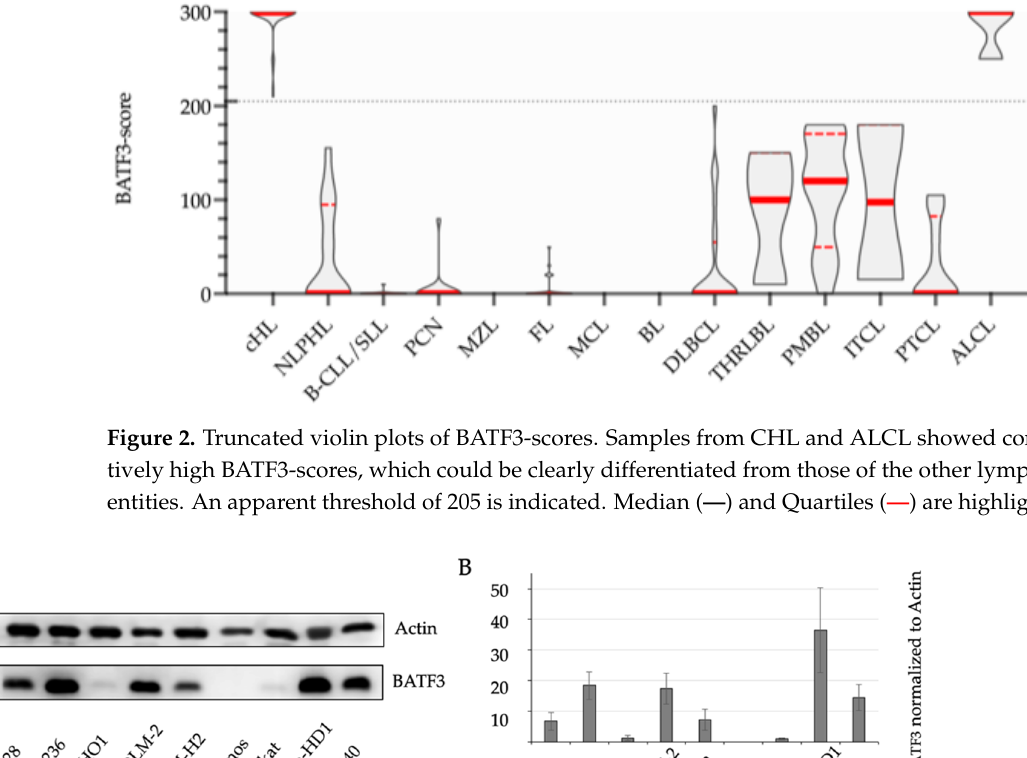
Figure 3. Characterization of BATF3 expression in cHL cell lines. Western blots of cell lysates from cHL (L-428, L-1236, U-HO1, HDLM-2, KM-H2, Sup-HD1, L-540), T-cell lymphoblastic lymphoma/Leukemia (T-LBL/ALL) (Jurkat) and BL (Ramos) were probed with anti-BATF3 AB and anti- β -actin AB. Anti-BATF3 AB labeled the 17-kDa BATF3-protein in cHL and in T-LBL/ALL, while BL cells were not reactive ( A ). Quantification of the amount of BATF3 protein as depicted in A. Mean value of 3 independent experiments (see Figure S1 in Supplementary Materials) is shown ( B ).